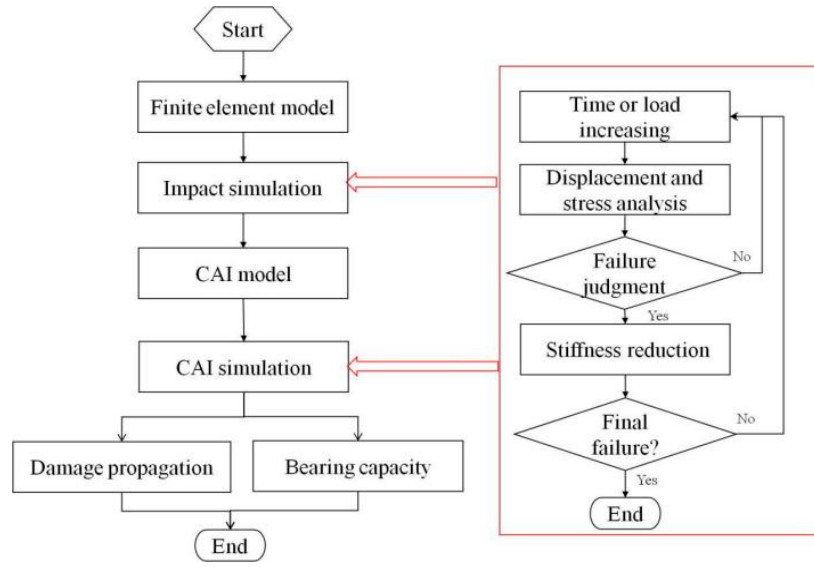
Figure 6. Flow chart of finite element analysis.